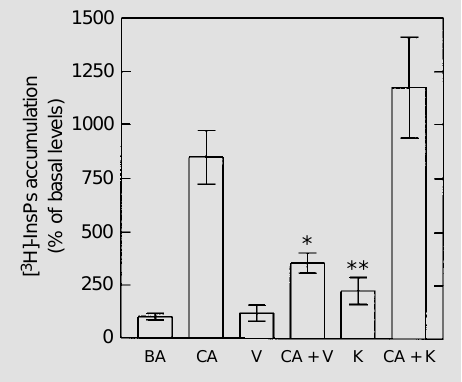
Figure 2 - Inhibition of the carba- chol (CA)-induced [ 3 H]-InsPs ac- cumulation by depolarizing agents in retinas of 14-day-old embryos (E14). Veratridine (V), at 50 µM, and 50 mM KCl (K) were added 10 min before 100 µM carbachol. Data are reported as mean ± SEM (error bars) for 3 to 6 experiments performed in duplicate. No significant differ- ence was observed between non-stimulated retinas and those incubated only with ver- atridine. * P<0.01 vs CA; **P<0.05 vs basal levels (BA) (Student t